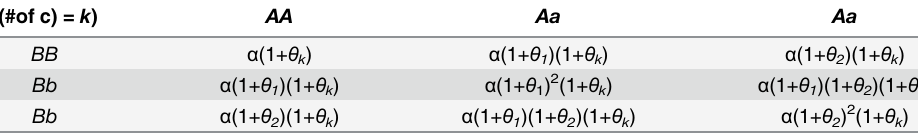
Table 1. Odds table for simulation studies and binary trait in three causal SNP model ( θ 0 = 0). ((#of c) = k